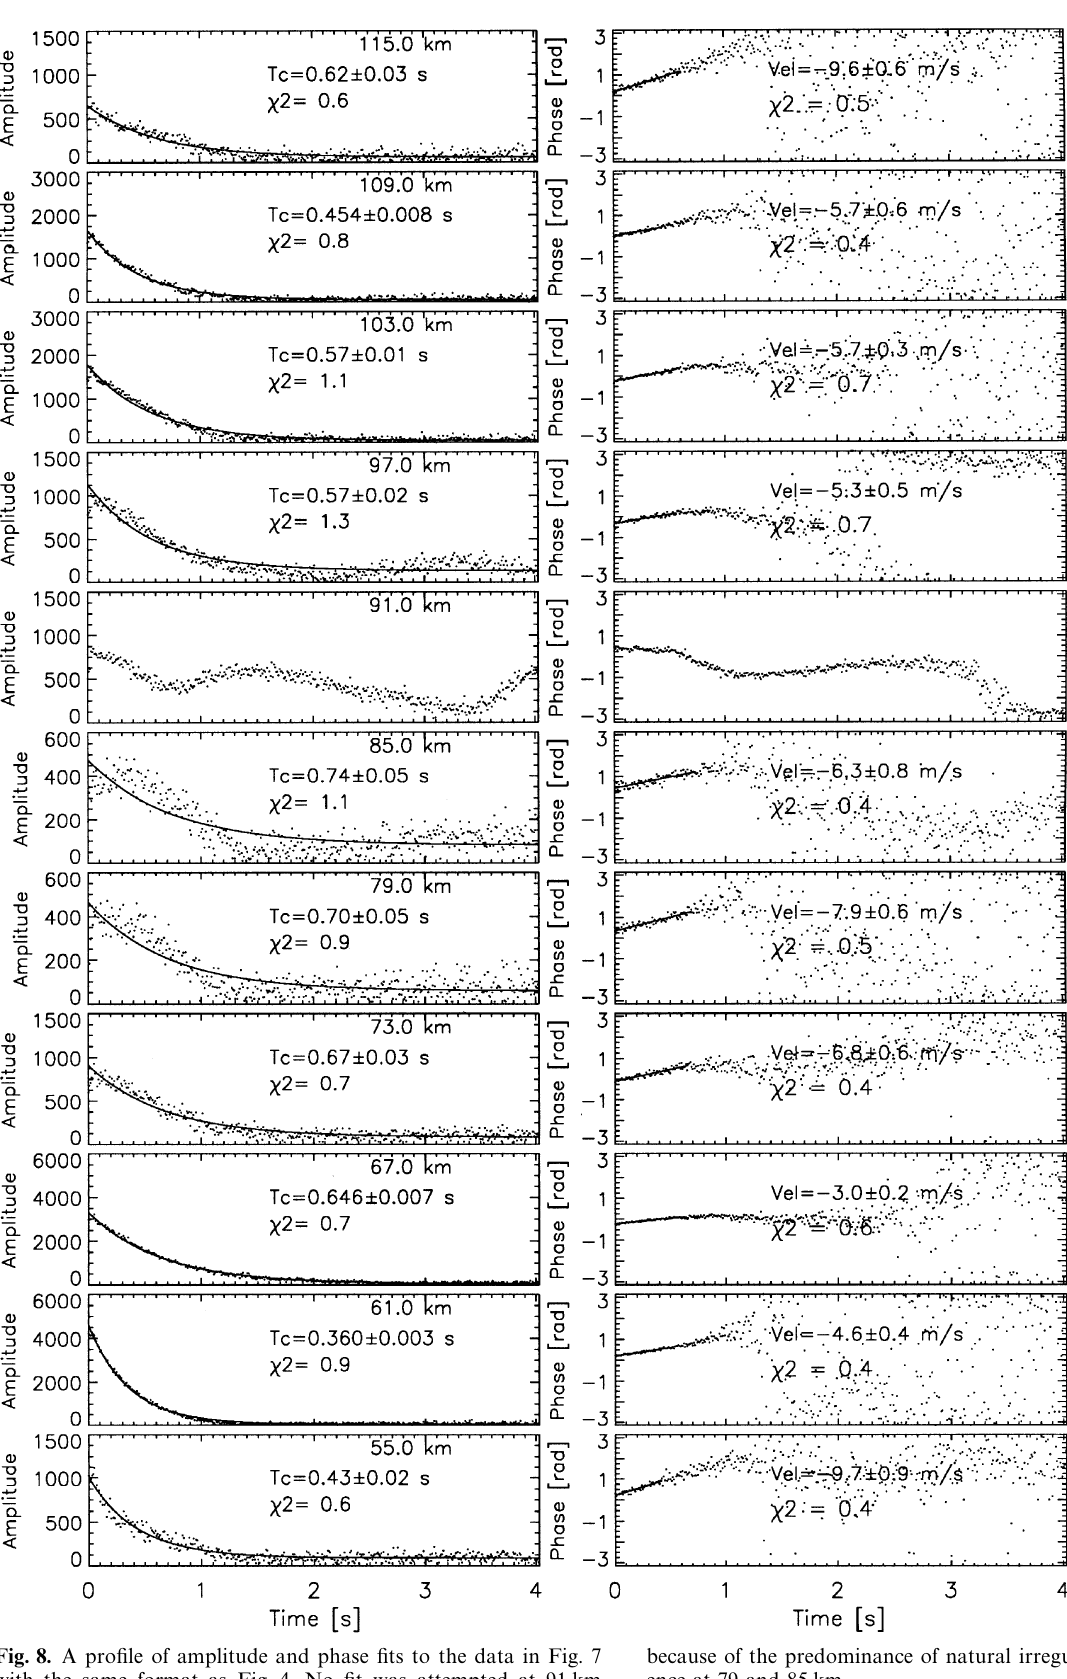
Fig. 8. A profile of amplitude and phase fits to the data in Fig. 7 with the same format as Fig. 4. No fit was attempted at 91 km